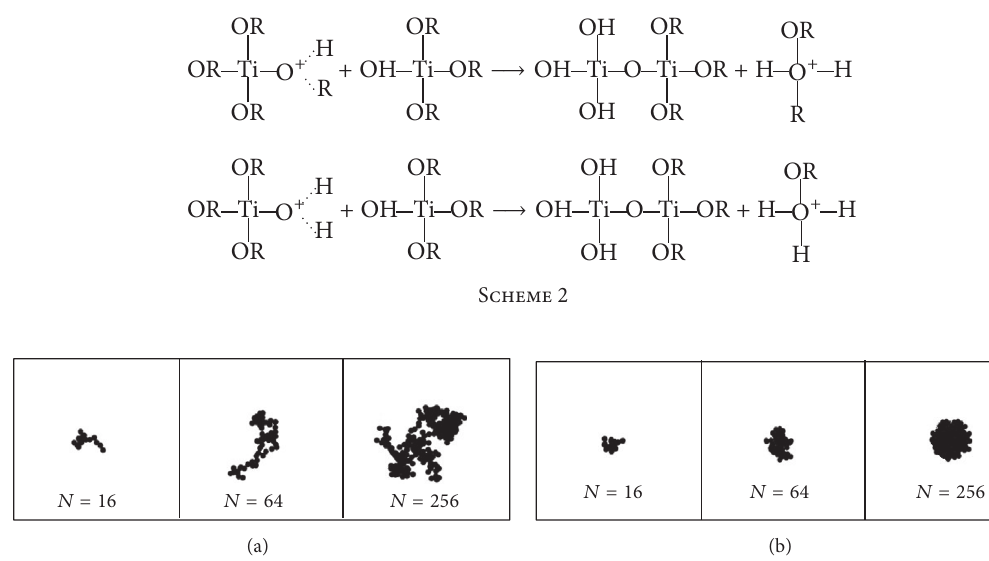
Figure 2: Particle growth mechanism: (a) clusters aggregation and (b) monomers addition.